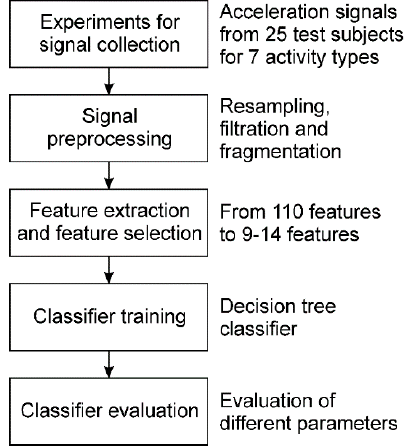
Figure 1. A summary of methods used in the study.